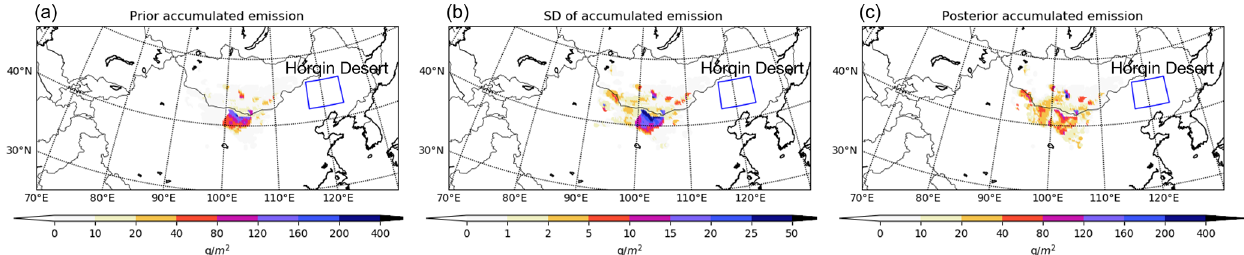
Figure 4. Accumulated prior dust emissions from 2 May 2017, 15:00 (CST) to 4 May, 15:00 (a) as well as the assumed standard deviation (b) and the estimate after assimilation (c) . This figure is adapted from Fig. 2 in Jin et al.